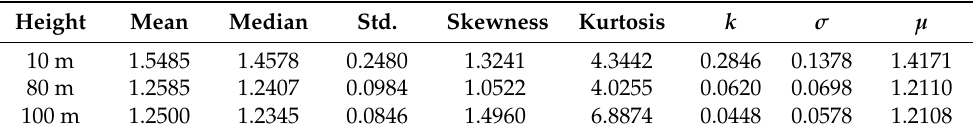
Figure 15. Gust factor at different heights (10 m, 80 m, 100 m). Table 6. Statistical results of the gust